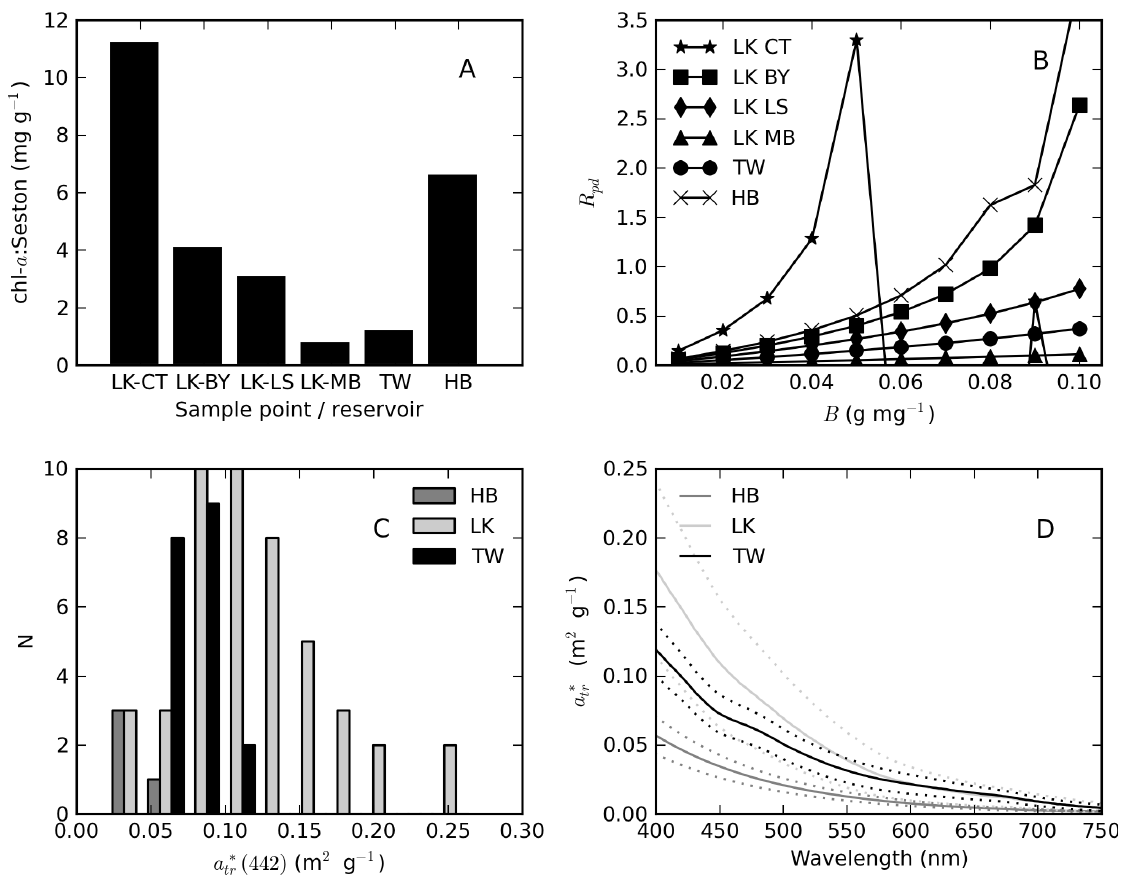
Figure 12. ( A ) Mean chl- a :seston values and ( B ) mean R of β between 0.01 and 0.10 g · mg − 1 for sample points in Loskop, Theewaterskloof and Hartbeespoort; ( C ) histograms of a ∗ showing standard deviations ( ·· ) for each